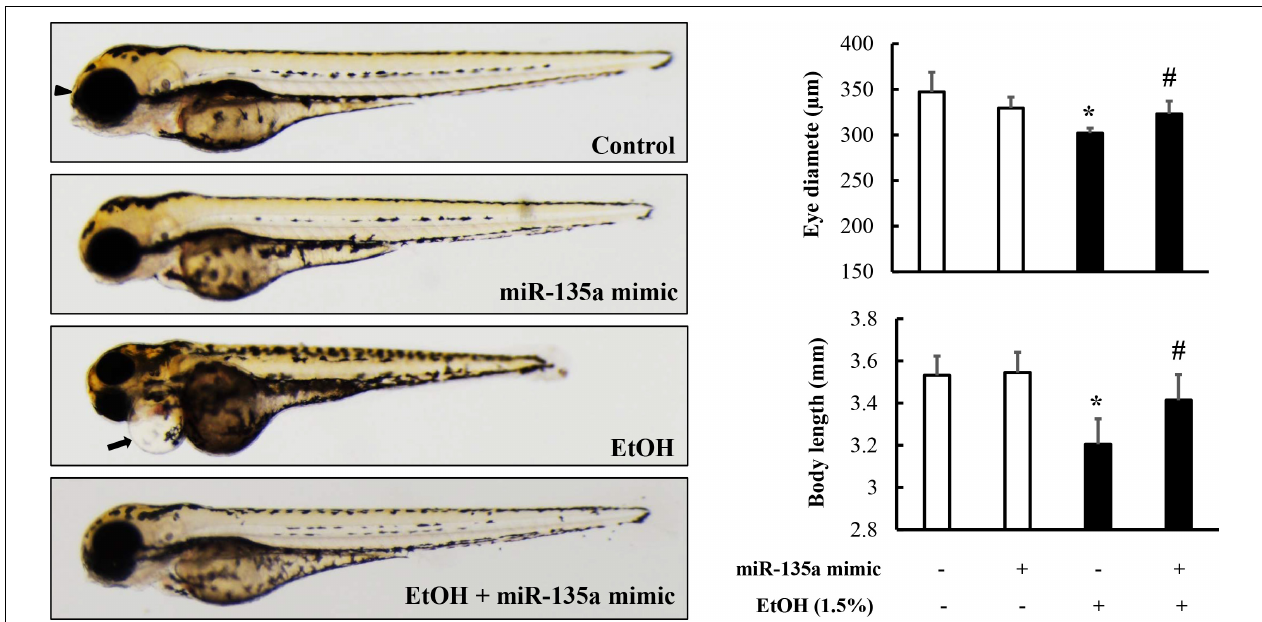
FIGURE 6 | Microinjection of miR-135a mimics diminished ethanol-induced growth retardation and dysmorphology in zebrafish larvae. Embryos microinjected with control or miR-135a mimics were treated with 1.5% ethanol from 3 to 24 h post-fertilization (hpf). Zebrafish larvae were collected at 4 days post-fertilization (dpf) for morphological analysis. Analysis of ethanol-induced growth retardation and dysmorphology was performed by using a stereoscopic microscope. The black arrows indicate the heart and the arrowheads indicate eye. Data represent the mean ± SD of three separate experiments. * p < 0.05 vs. control; # p < 0.05 vs.